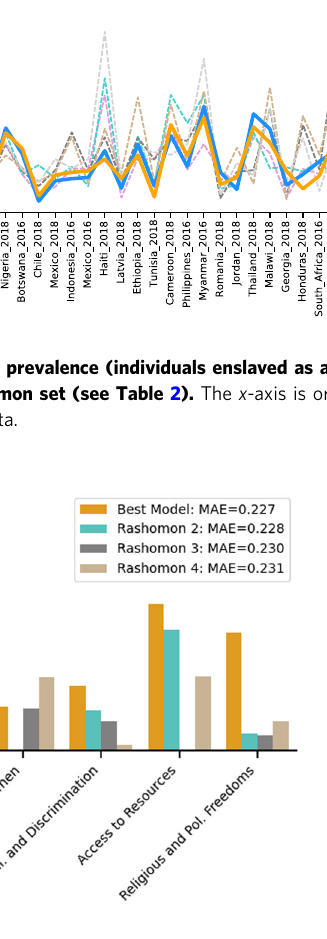
Fig. 5 A comparison of variable importance ratings to other Rashomon set models. Comparisons were only made between models in the same model class as the best model (NMF → DT (MF)).